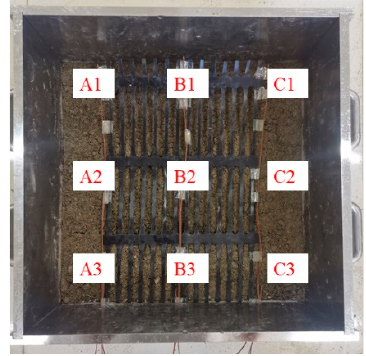
Figure 6. Arrangement of soil temperature measuring points in the